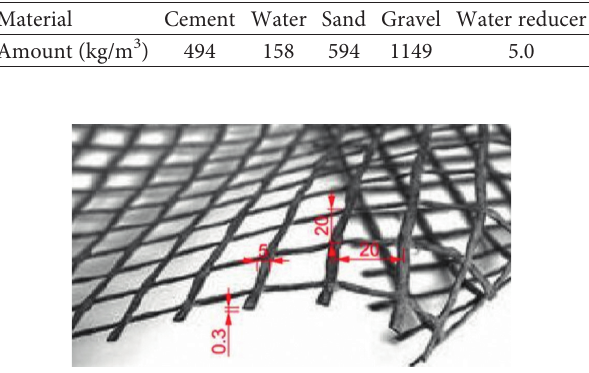
Figure 1: Dimensions of CFRP grid